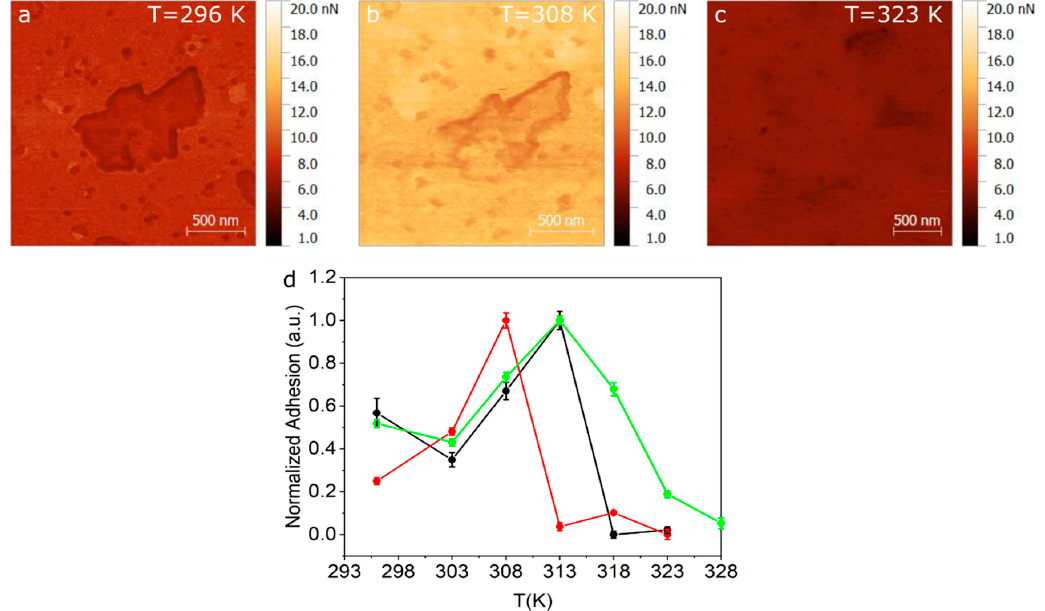
Figure 4. Adhesion maps obtained using QI TM mode for ( a ) 296 K ( b ) 308 K and ( c ) 323 K. ( d ) Normalized adhesion taken for three different samples as a function of temperature.